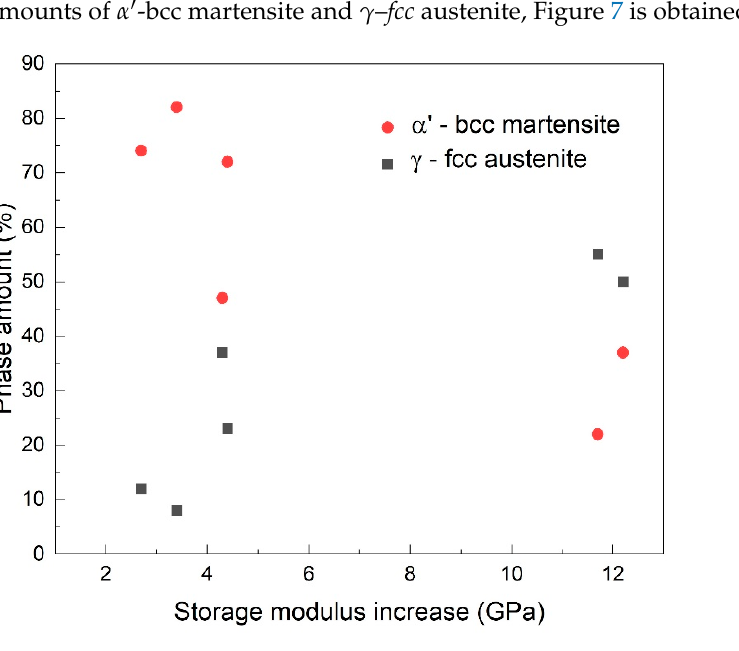
Figure 7. The relationship between storage modulus increase and the amounts of α′ -bcc martensite and γ – fcc austenite.